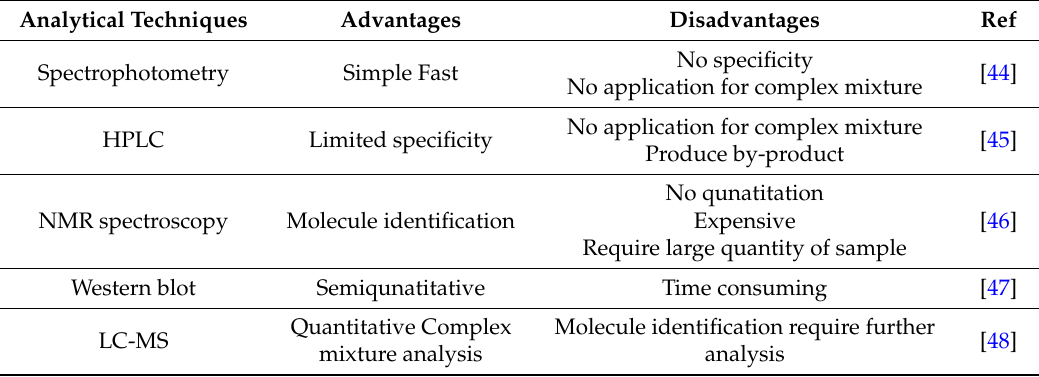
Table 3. Analytical techniques identifying reactive carbonyl species sequestering agents.